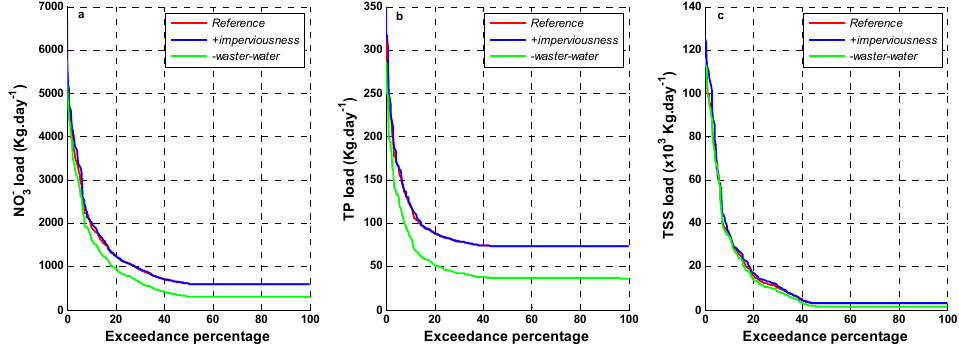
Figure 7. Duration curves for scenarios reference (red line), +imperviousness (blue line) and -waster_water (green line) for NO 3 − ( a ), TP ( b ) and TSS ( c ). The plateau at high exceedance percentage corresponds to dry weather periods.